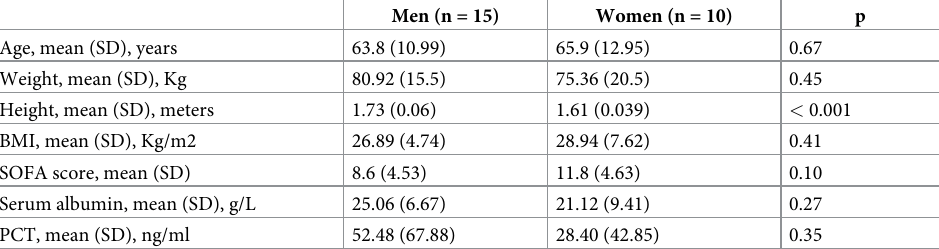
Table 1. Patient characteristics at admission (n =